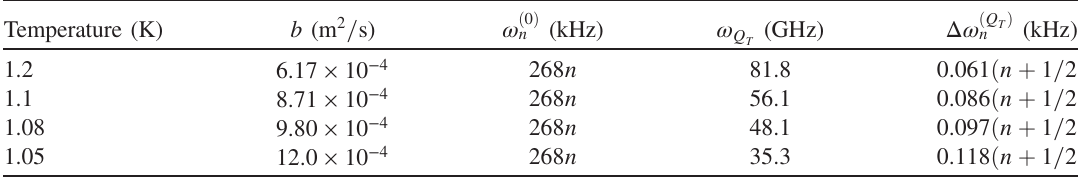
TABLE III. Resonant frequencies of standing modes at different temperatures. Temperature